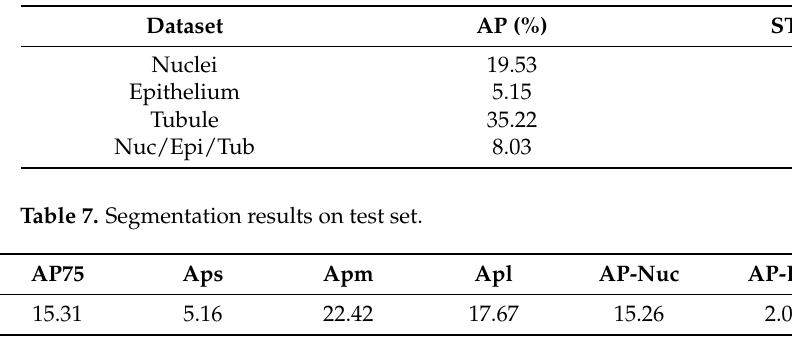
Table 6. Results for instance segmentation task on JPATHOL on validation set.